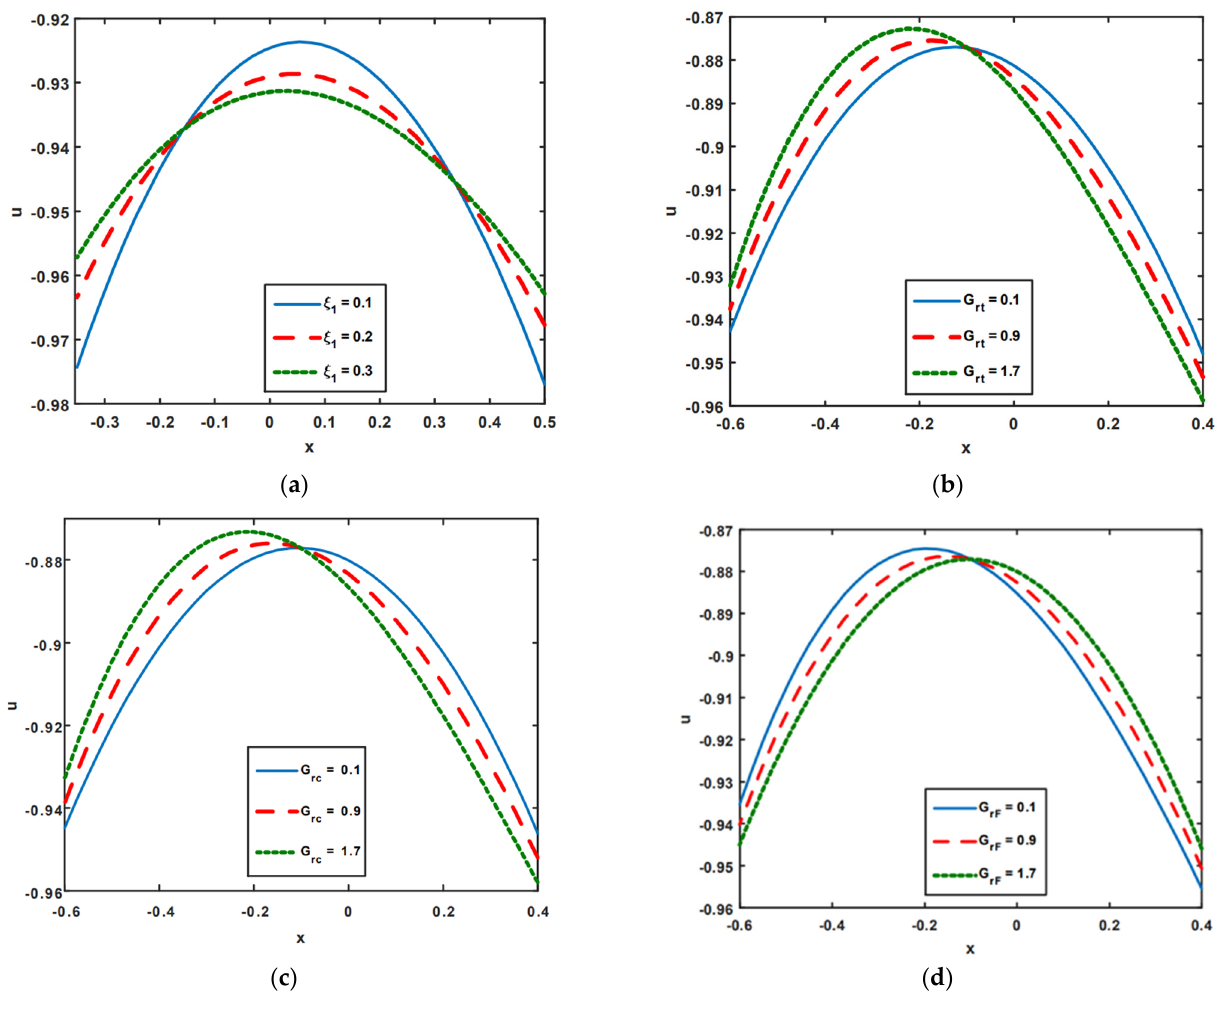
Figure 1. (a–d) Velocity impact on 𝜉 (cid:2869) , 𝐺 (cid:3045)(cid:3047) , 𝐺 (cid:3045)(cid:3030) , and 𝐺 (cid:3045)(cid:3007) . Figure 1. ( a – d ) Velocity impact on ξ 1 , G rt , G rc , and G rF